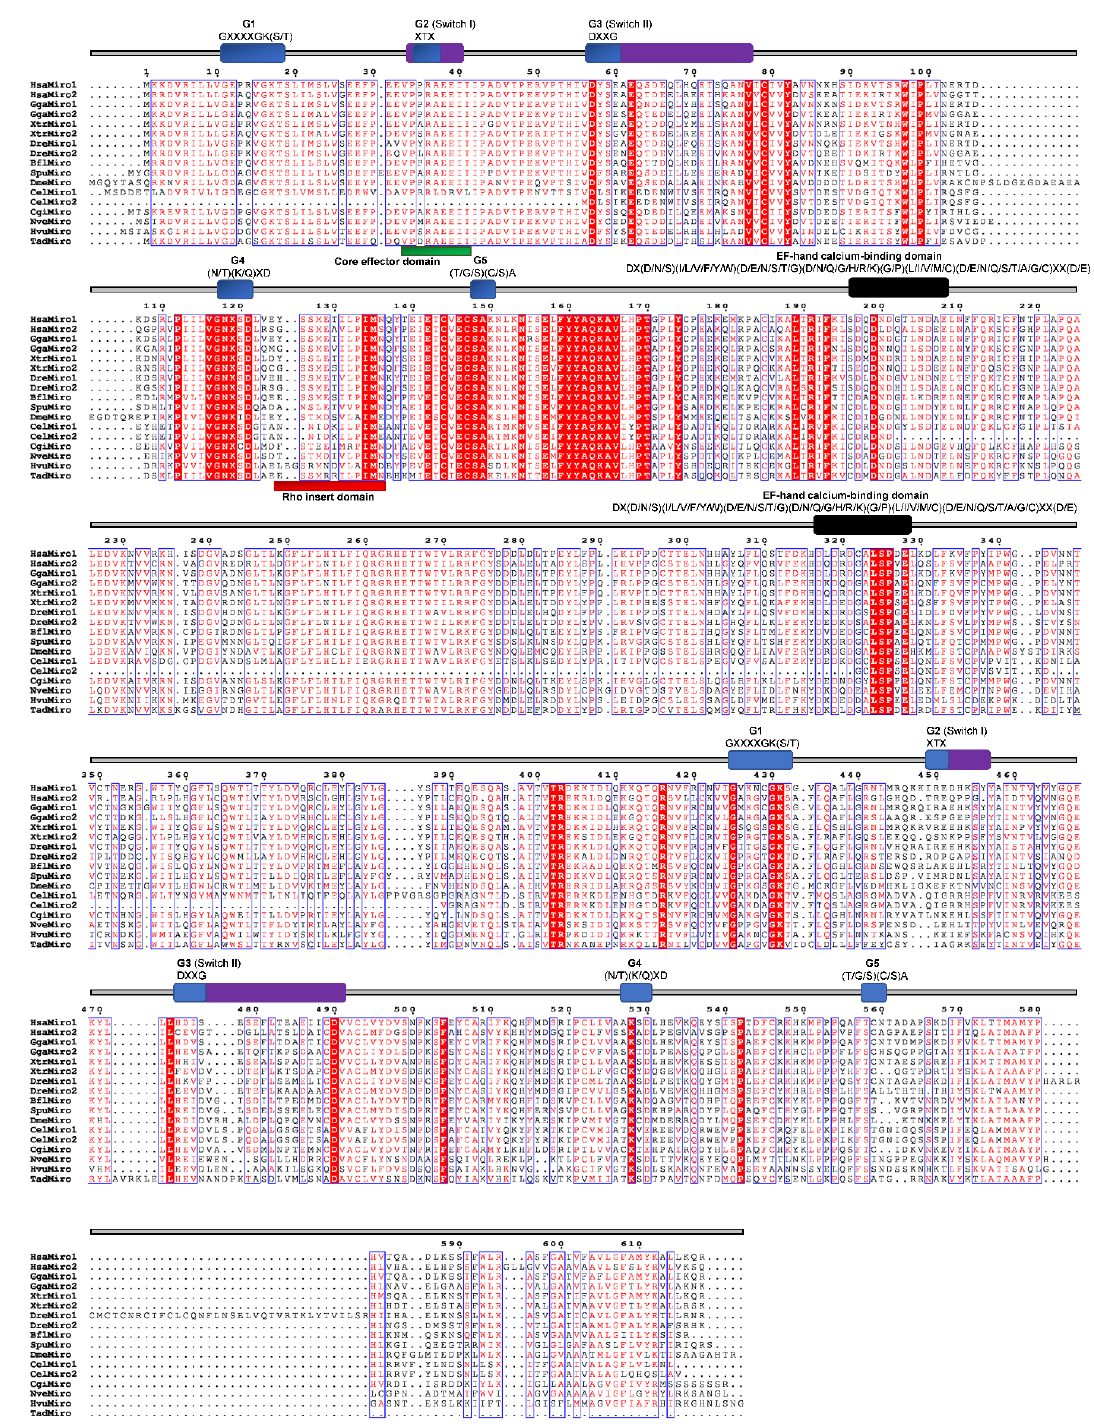
Figure 11. Sequence alignment of the Miro subfamily. The amino acid sequences of Miro GTPases were aligned using ClustalX, the secondary structures predicted using ESPript. Regions of the Miro proteins are indicated above the alignment; blue are the G domains (G1, G2, G3, G4, and G5) domains; purple represent the switch domains (I and II) and black the EF hand calcium binding domains with their respected motifs. Blue frames are indicators of the conserved residues; white letters in red boxes represent identity, red letters in white boxes represent